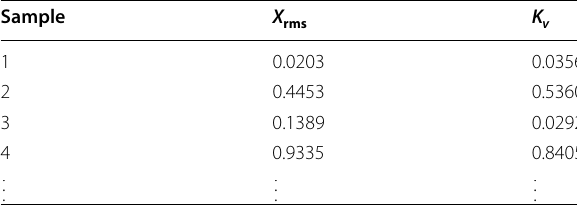
and K of different samples rms v